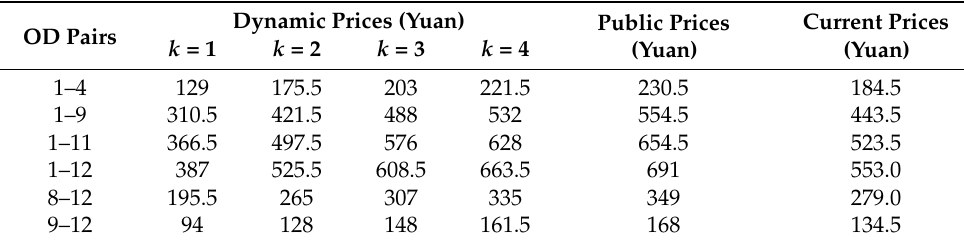
Table 6. Ticket prices for different ticket pre-sale